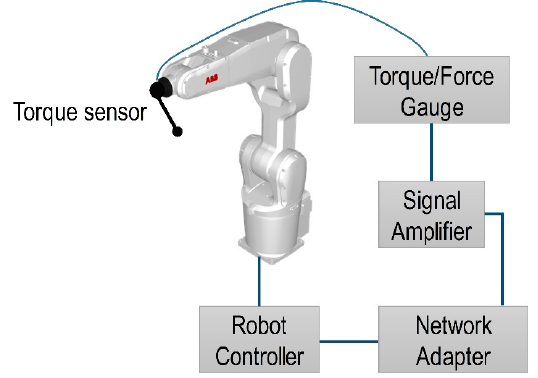
Figure 19. Schematics of a robotized polymer sheet SPIF step-by-step feedback system.